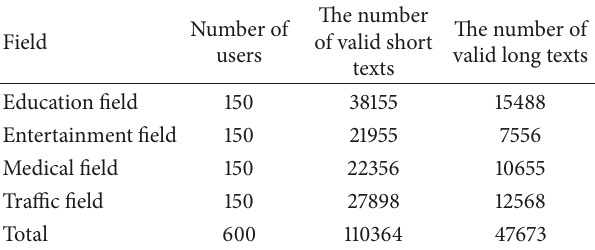
Table 1: Experimental data